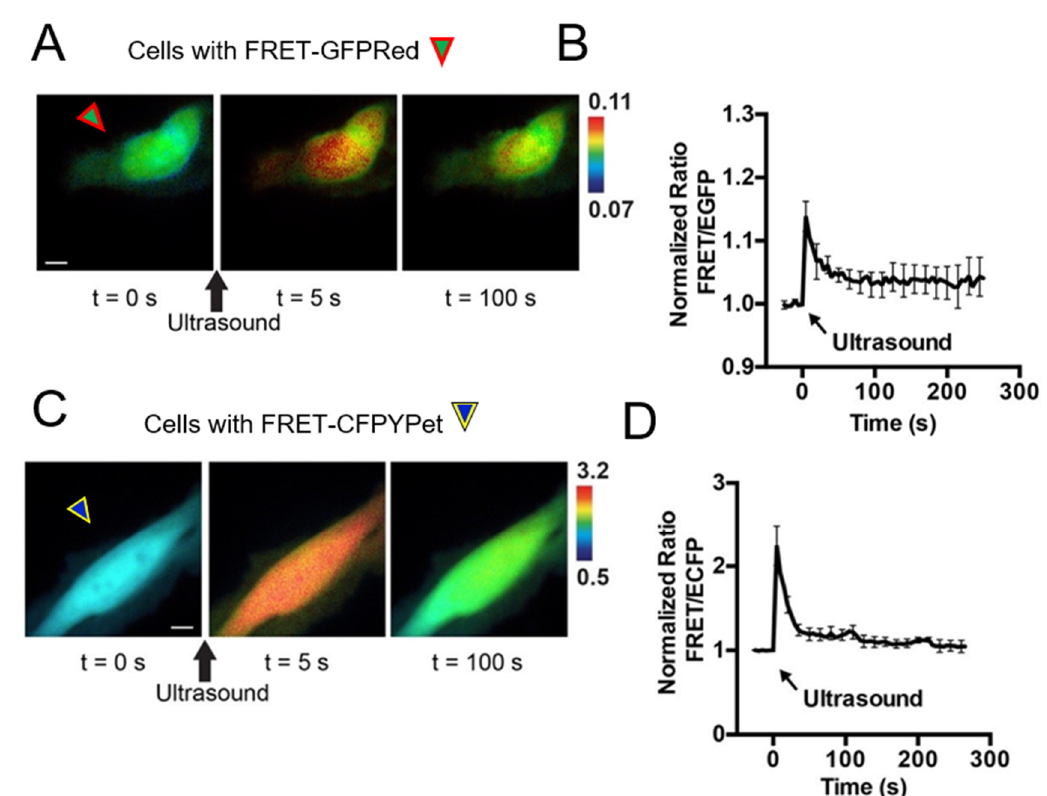
Figure 6. A new FRET-based Ca 2+ biosensor with EGFP and FusionRed fluorophores (FRET-GFPRed) stimulated with high frequency ultrasound. A FRET-based Ca 2+ biosensor with ECFP and YPet (FRET-CFPYPet) was used for comparison. FRET-GFPRed and FRET-CFPYPet were transfected by high frequency ultrasound, which can specifically transfect single cells with the desired FRET biosensor. ( A ) Representative FRET/EGFP signal ratio images of FRET-GFPRed in a HeLa cell before (t = 0 s), 5 s, and 100 s after ultrasound stimulation are presented. FRET images were taken using the filter setting GR as shown in Figure 3A. ( B ) Time course of the FRET/EGFP signal ratio of FRET-GFPRed after ultrasound stimulation is presented. ( C ) Representative FRET/ECFP signal ratio images of FRET-CFPYPet before (t = 0 s), 5 s, and 100 s after ultrasound stimulation is shown. FRET images were taken using the filter setting CY as shown in Figure 3B. ( D ) Time course of the FRET/ECFP ratio of the FRET-CFPYPet after ultrasound stimulation (t = 0) is presented. Green arrowheads surrounded by red lines indicate HeLa cells transfected with FRET-GFPRed. Blue arrowheads surrounded by yellow lines represent cells transfected with FRET-CFPYPet. Black arrows indicate ultrasound stimulation. The duration of the stimulation was from 5 to 10 µs. Scale bars represent 10 µm. Error bars represent +/- one SEM.